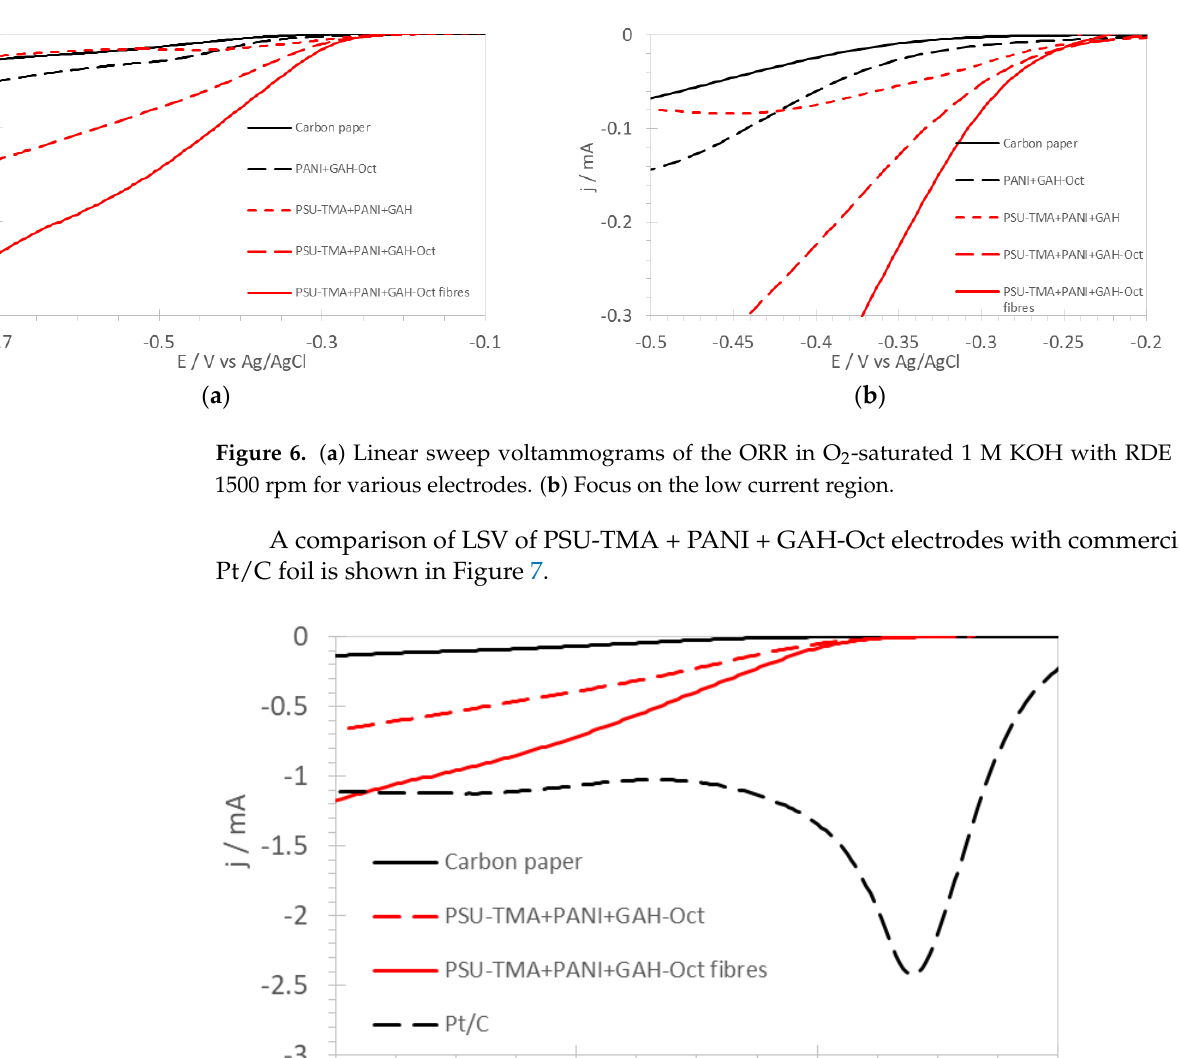
Figure 8. Schematic representation of the ORR on carbon quantum dots. The presented results show that ORR electrodes containing GAH-Oct have a higher catalytic activity than that with GAH, although the latter electrode has a higher electro- chemically surface area. A convincing interpretation can be based on the position of ni- trogen atoms inside the CQD and their influence on the ORR electrocatalytic activity. It was demonstrated previously that graphitic nitrogen has a distinctly higher catalytic ac- tivity than pyridinic or pyrrolic nitrogen [19]. We have shown by XPS analysis that GAH-Oct contains the greatest amount of nitrogen and indeed essentially in graphitic